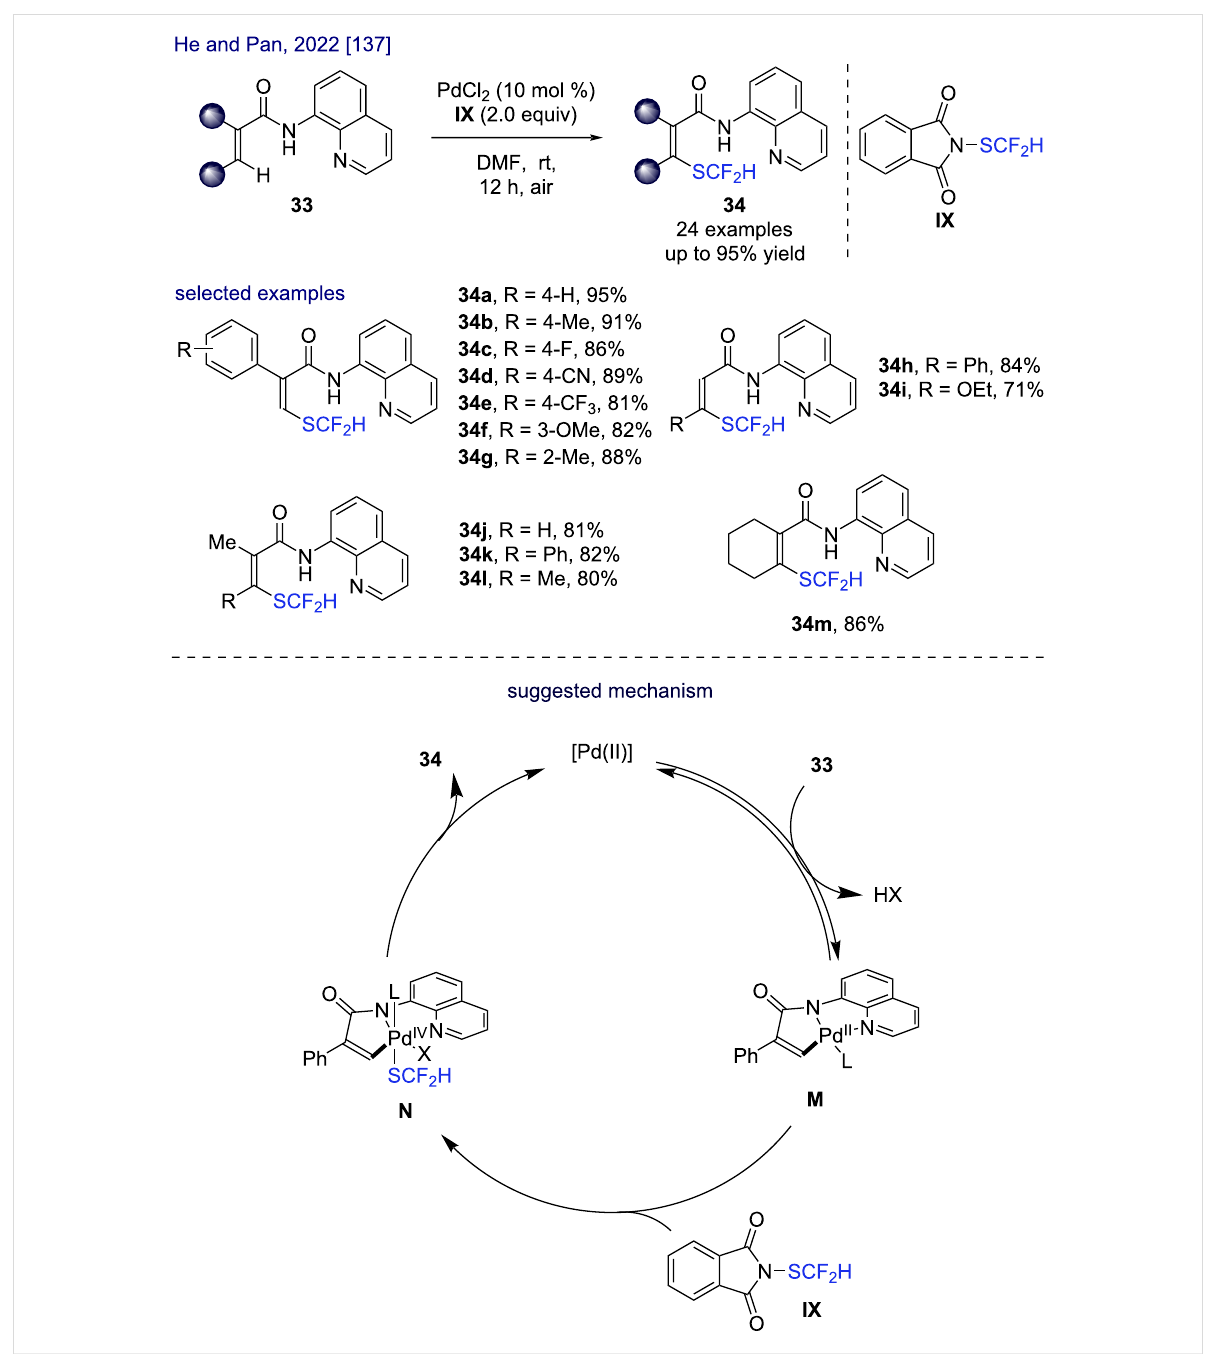
Scheme 15: Regio- and diastereoselective difluoromethylthiolation of acrylamides under palladium catalysis reported by He and Pan